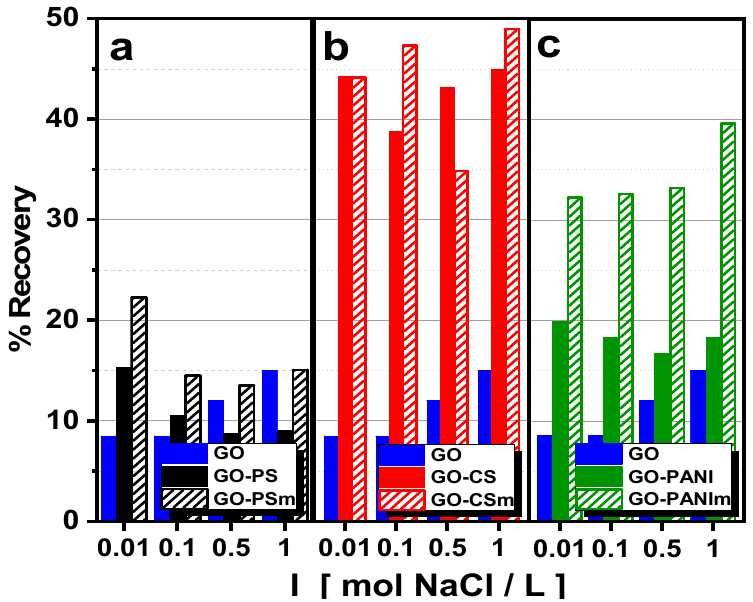
Figure 8. Effect of ionic strength on adsorption of BPA by ( a ) GO–PS and GO–PSm, ( b ) GO–CS and GO–CSm and ( c ) GO–PANI and GO–PANIm, and GO as reference.